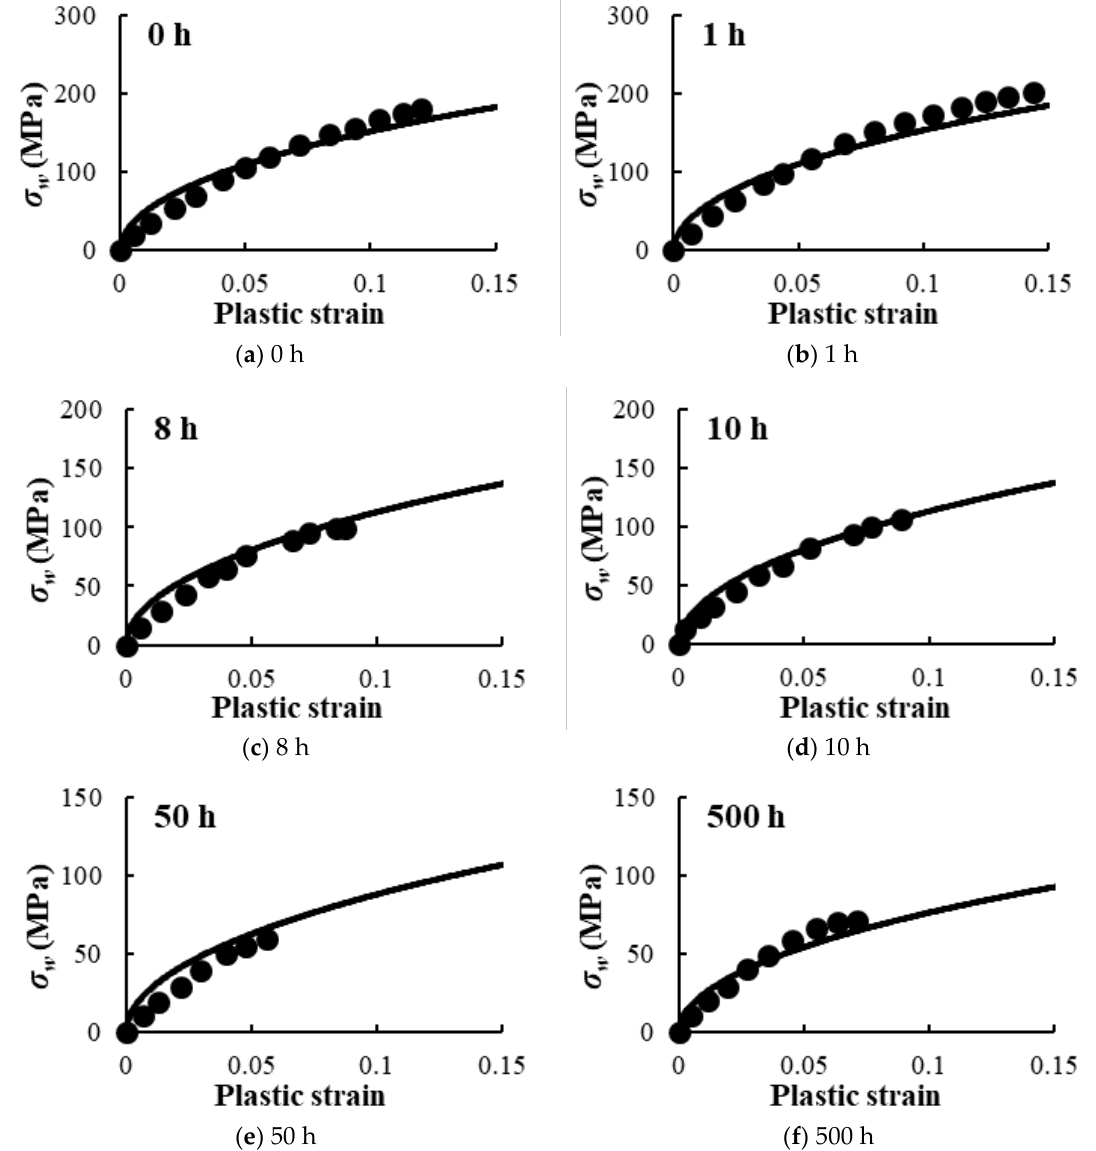
Figure 7. Comparison of the work hardening behaviour of AA2198 with different artificially aged states (time) at 155 °C from experiments (symbols [34]) and modelling results from Table 3 (lines): ( a ) not-aged; ( b ) 1h aged; ( c ) 8h aged; ( d ) 10h aged; ( e ) 50h aged and ( f ) 500h aged.